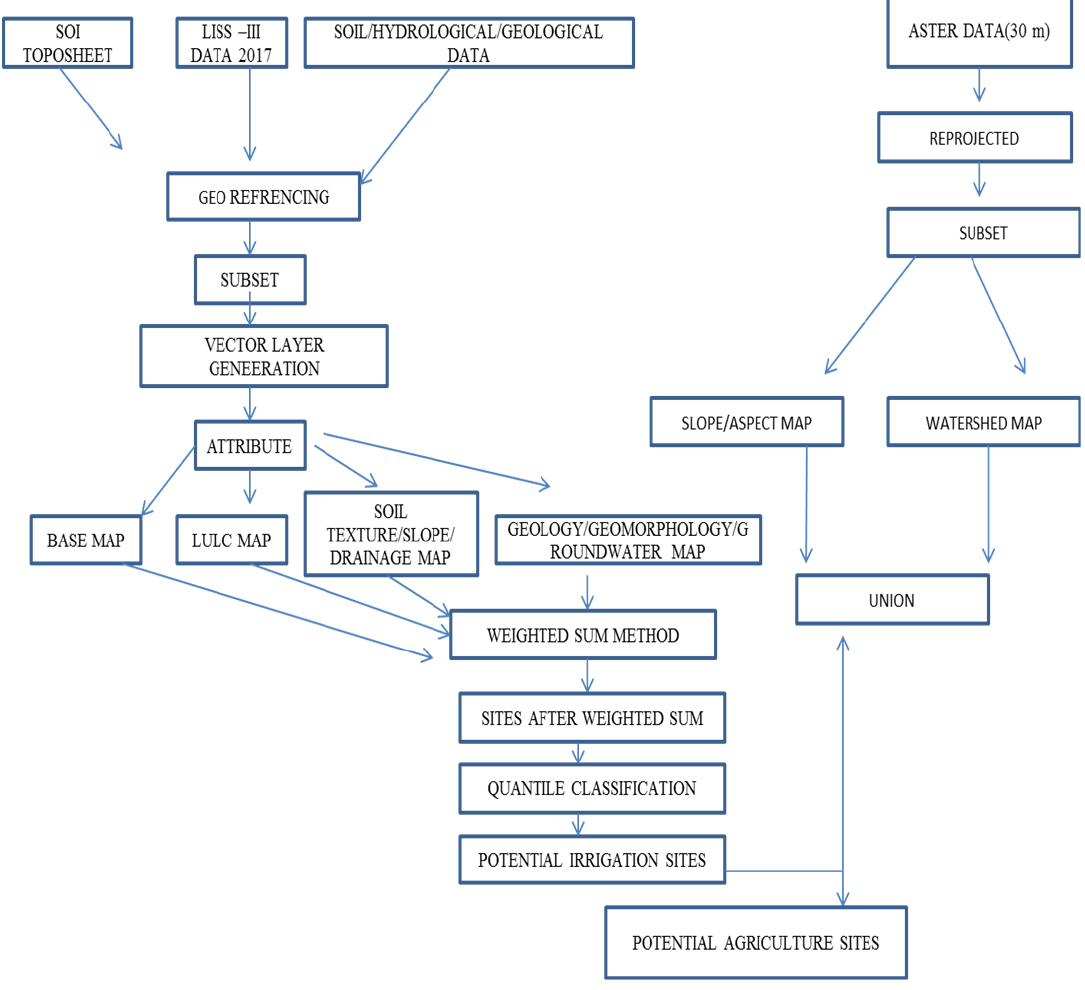
Fig.2: Flow Diagram of the